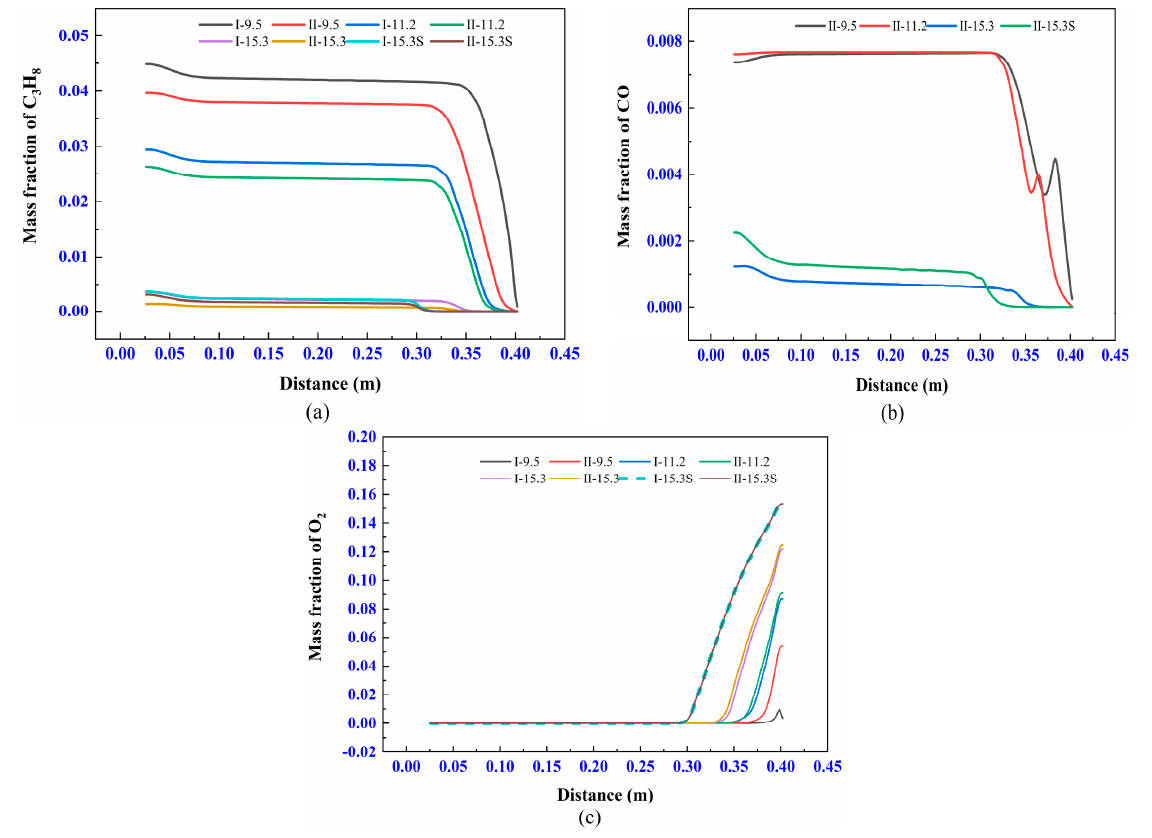
Figure 12. Mass fraction of gas species at the axis of the model: ( a ) C 3 H 8 , ( b ) CO, and ( c ) O 2 .